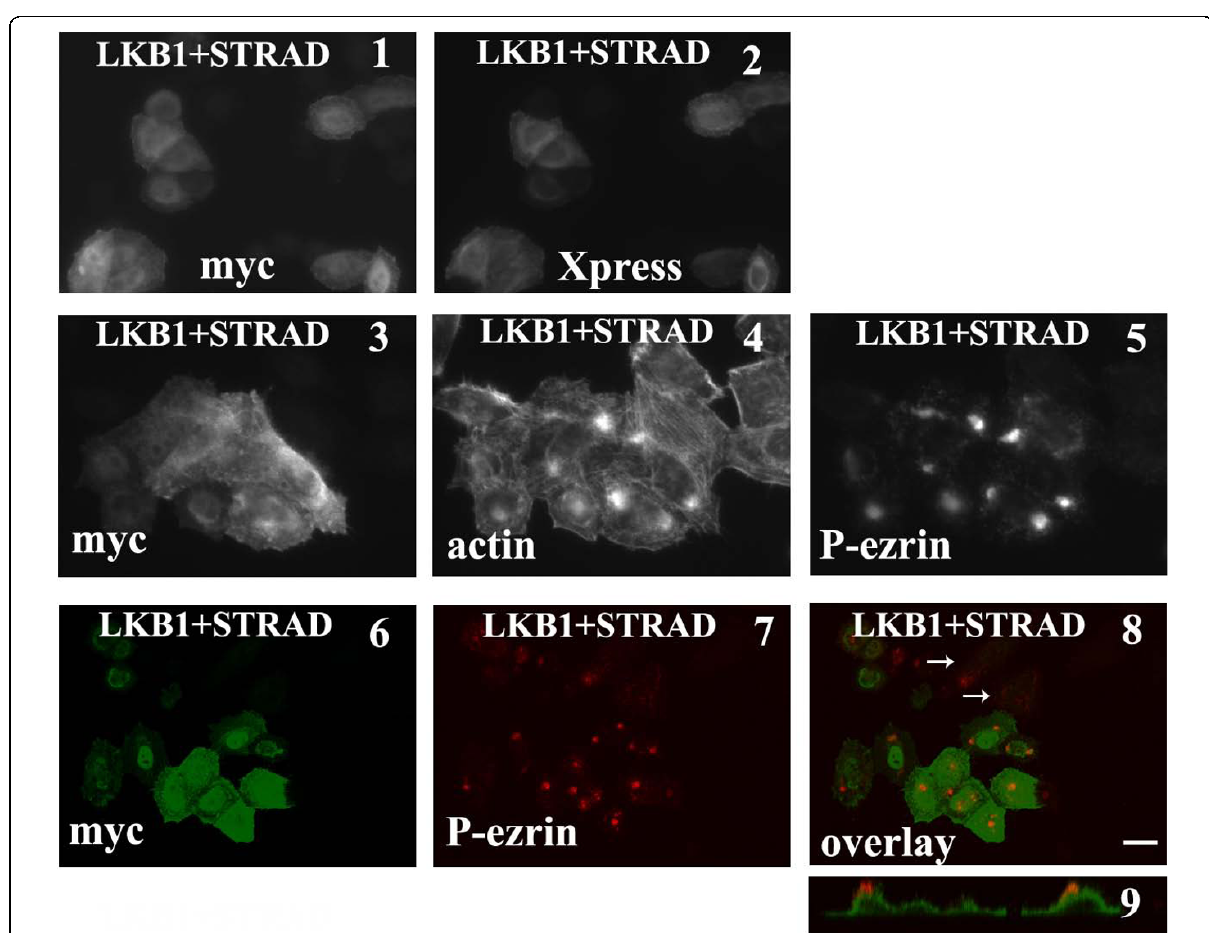
Figure 7 Co-transfection of LKB1 and STRAD leads to actin puncta associated with phospho-ezrin . Panels 1 & 2 : HeLa-S3 cells were transfected with myc-LKB1 and pcDNA-HisMax-STRAD. Cells were stained with anti-myc or anti-Xpress antibodies. LKB1 partially relocated into the cytosol upon STRAD expression. Panels 3-5 : Cells were transfected with myc-LKB1 and pcDNA-HisMax-STRAD and visualized with anti-myc antibody, anti-phospho-ezrin antibody and phalloidin to visualize actin. Phosphorylated ezrin is associated with actin punctas in transfected cells. Panels 6-8 : Cells were transfected with myc-LKB1 and pcDNA-HisMax-STRAD and visualized with anti-myc antibody and anti-phospho-ezrin antibody. The basal level of phosphorylated ezrin can be seen in untransfected cells (white arrows, panel 7) . Panel 9 : Z-section image of cells in panel 7 showing puncta of phosphorylated ezrin present on dorsal surface. Scale bar = 20 μ